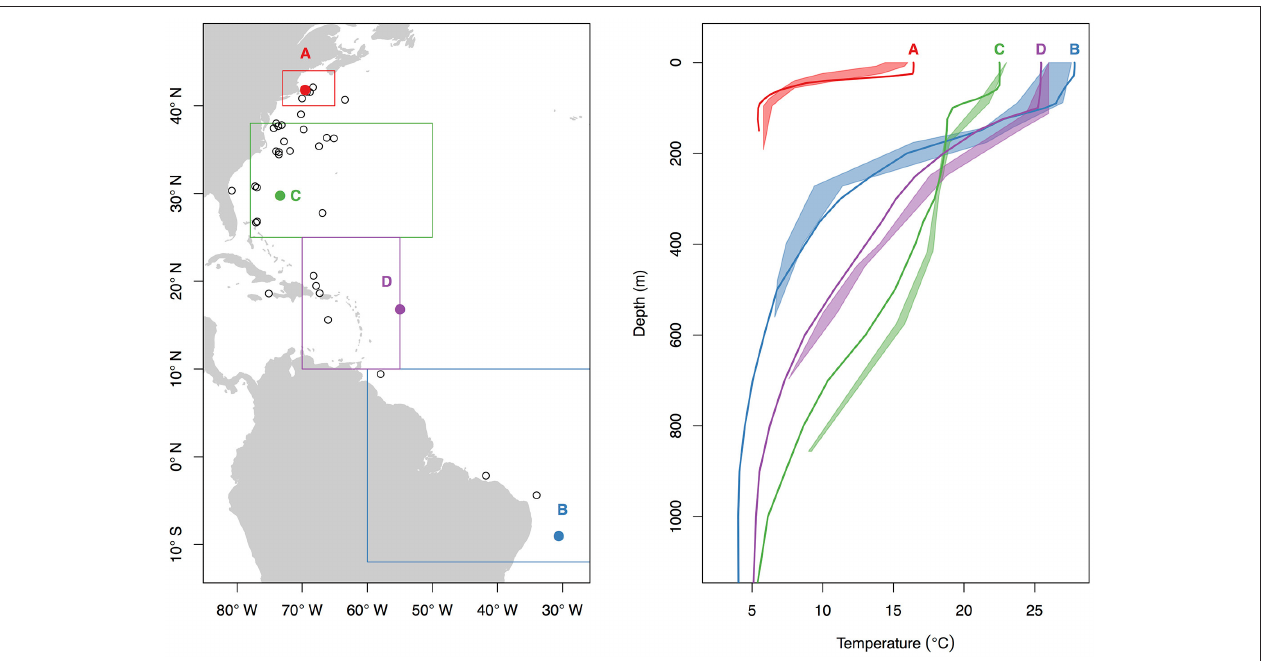
FIGURE 1 | Example depth-temperature profile data from known pop-up locations of PSAT-tagged basking sharks. Selected, representative pop-up locations (color, Left ) from distinct regions of the study area were used to compare tag-based depth-temperature profiles (shaded from minimum to maximum recorded profile temperatures, Right ) to HYCOM profiles (lines, Right ) from the same time and location. Black circles (Left) represent all tag pop-up locations in this study. Bounding boxes show the oceanographic regions discussed in the text, Figure 7 , and Table 2 and correspond to New England (red), Sargasso Sea (green), Antillean Arc (purple) and South America